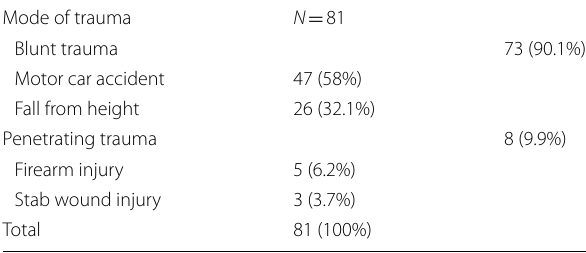
Data were expressed in form of frequency (percentage)